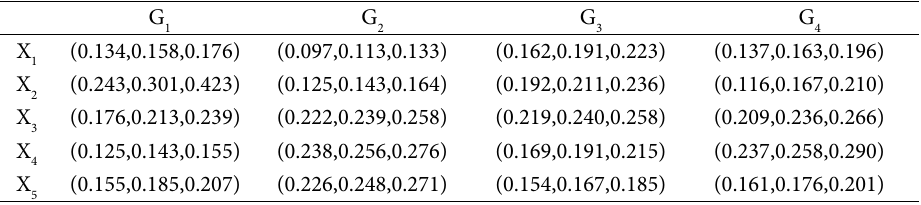
Table 5. Decision matrix 2 R 